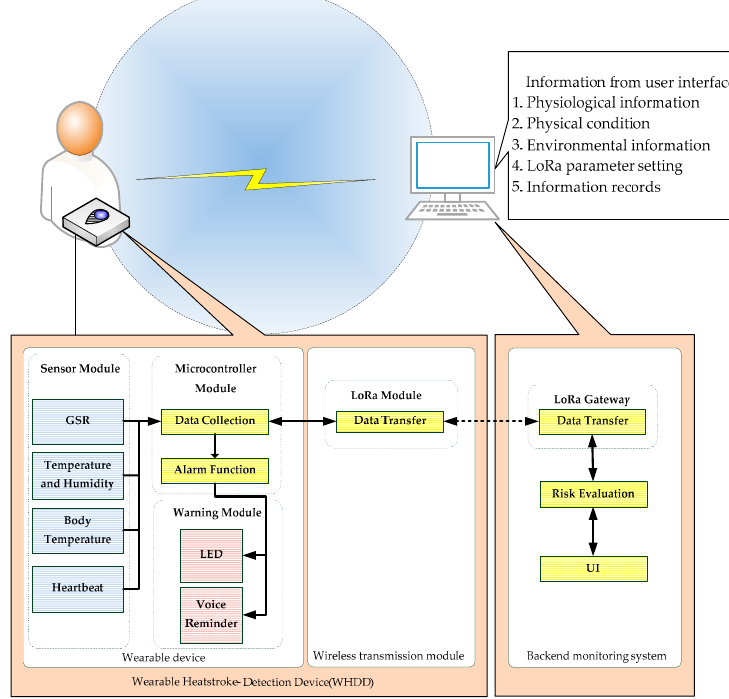
Figure 1. Architecture of the system.